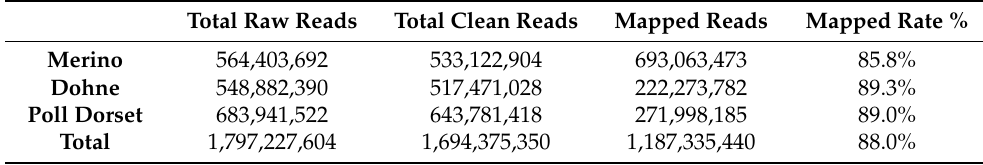
Table 2. Summary of reads quality and mapping in RNA sequencing